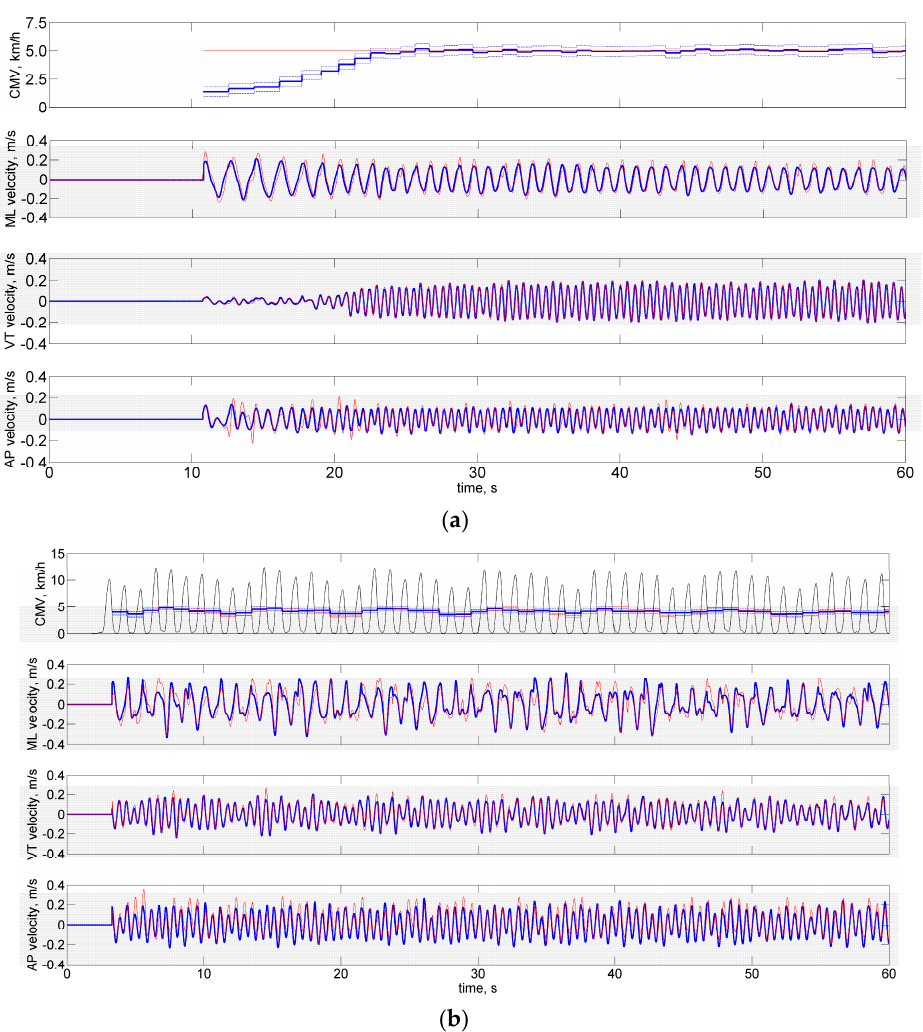
Figure 5. Representative time plots of the IMU and reference components of the pelvis instantaneous velocity, including transient and steady-state data: ( a ) TW dataset; and ( b ) OW dataset. The reference time functions are plotted in red; the time functions estimated with the proposed method are plotted in blue. In panel ( b ), the norm of the instantaneous velocity of the shank is plotted in black, and the bounds given by the predictive distribution are plotted using a dashed line.